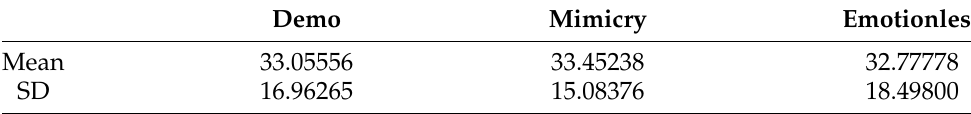
Table 4. Averaged NASA TLX scores by mode.